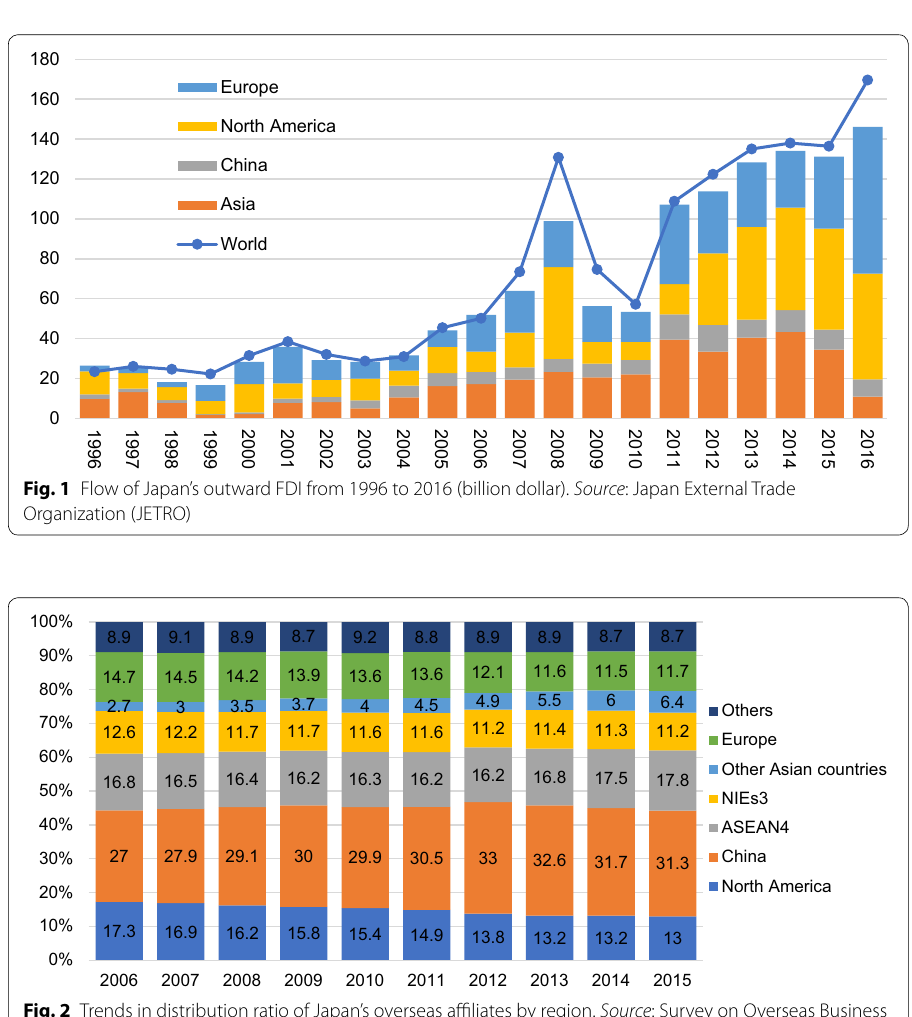
Fig. 2 Trends in distribution ratio of Japan’s overseas affiliates by region. Source : Survey on Overseas Business Activities by Japan Ministry of Economy, Trade and